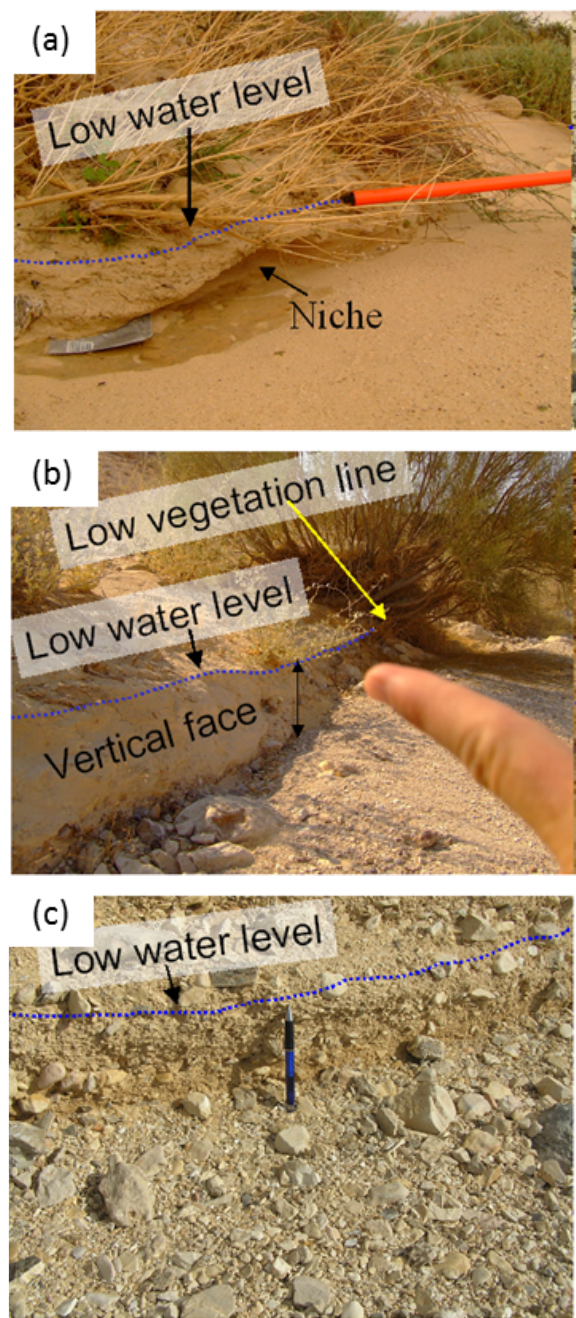
Fig. 2. Three types of low water marks that were identified in the alluvial channels: (a) a scour impressed on the lower bank (niche), (b) lowest vegetation line, and (c) change in pebble size.